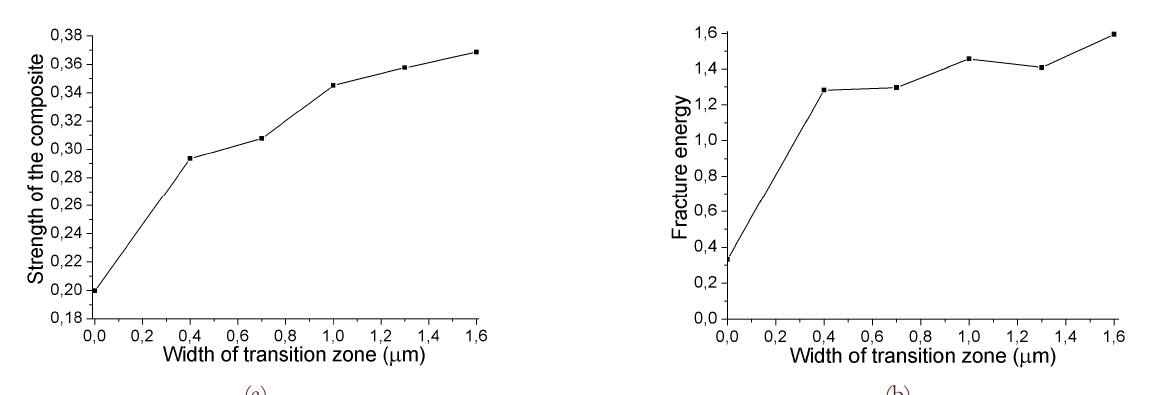
Figure 18: Strength (a) and fracture energy (b) in model metal-ceramic composite depending on width of transition zone. Value of composite strength is normalized by tensile strength of the binder NiCr